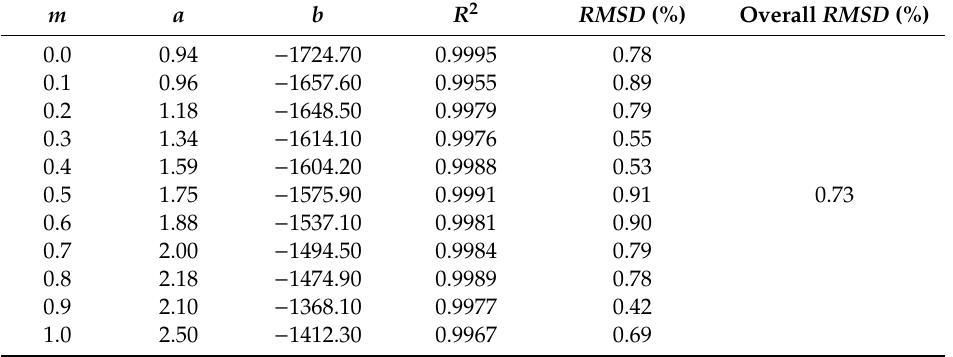
Table 5. The parameters of “Van’t Ho ff model ( a and b )” along with R 2 and % root mean square